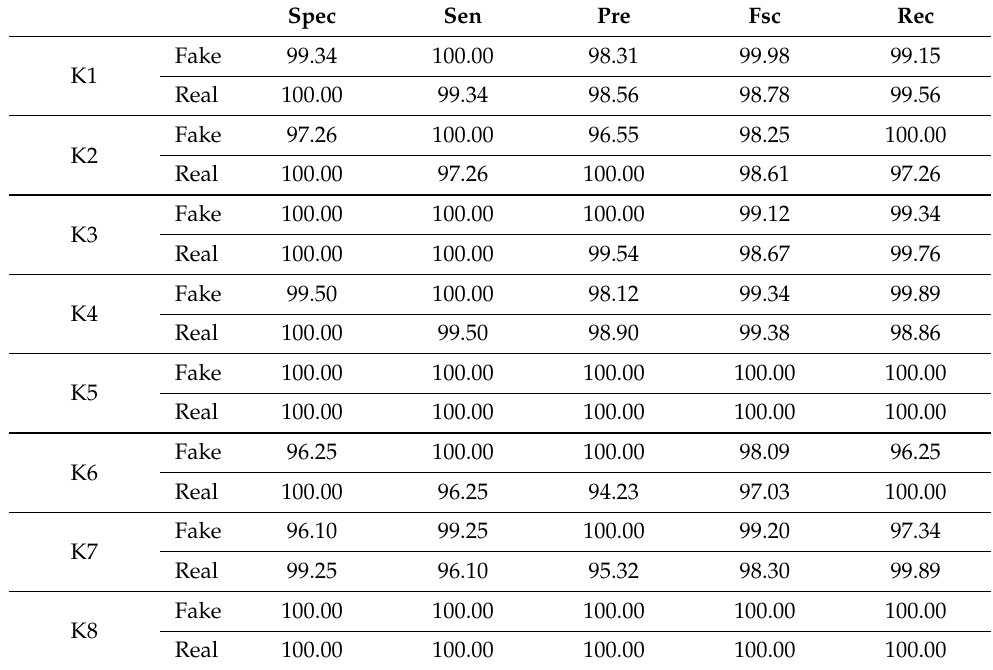
Table 3. K = 10-fold results (after 20 epochs, in %): for specificity (Spec), sensitivity (Sen), precision (Pre), F1 score (Fsc), and recall